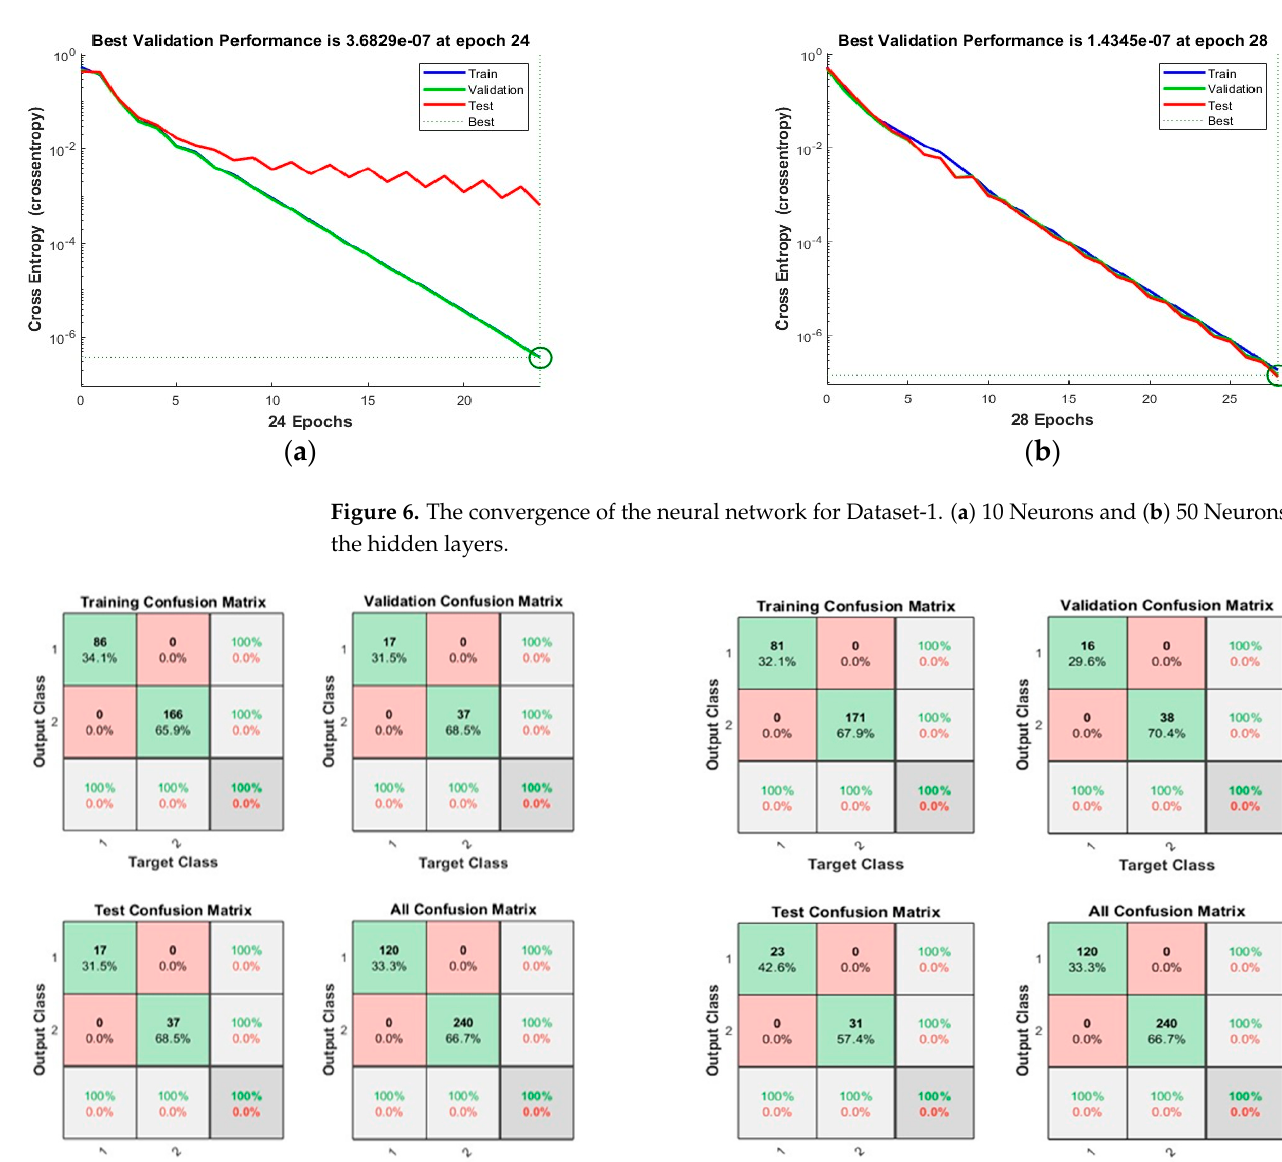
( b ) Figure 8. The convergence of the neural network for Dataset-2. ( a ) 10 Neurons and ( b ) 50 Neurons in the hidden layers.